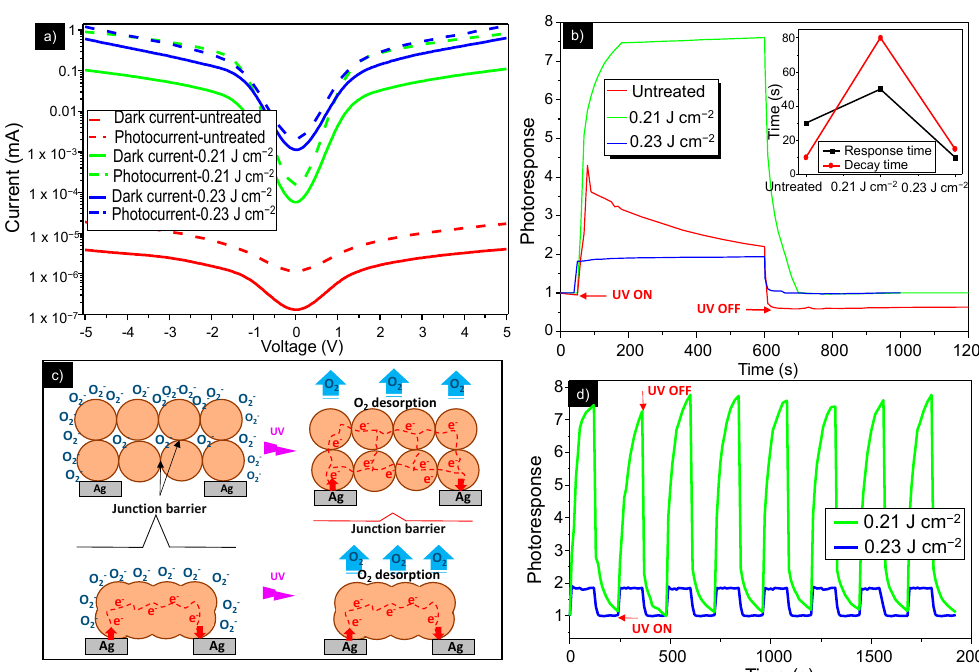
Figure 5. ( a ) I–V curves for uncoated and untreated samples and samples sintered at 0.21, and 0.23 J cm –2 with and without UV illumination. ( b ). Dynamic response behavior (response/recovery times) for the untreated and laser treated samples under UV illumination ( c ) Schematic diagram of the NP–NP junctions. ( d ) Time-resolved photoresponse of the ZnO device treated at 0.21 and 0.23 J cm − 2 under a continuous UV light rectangle pulse.